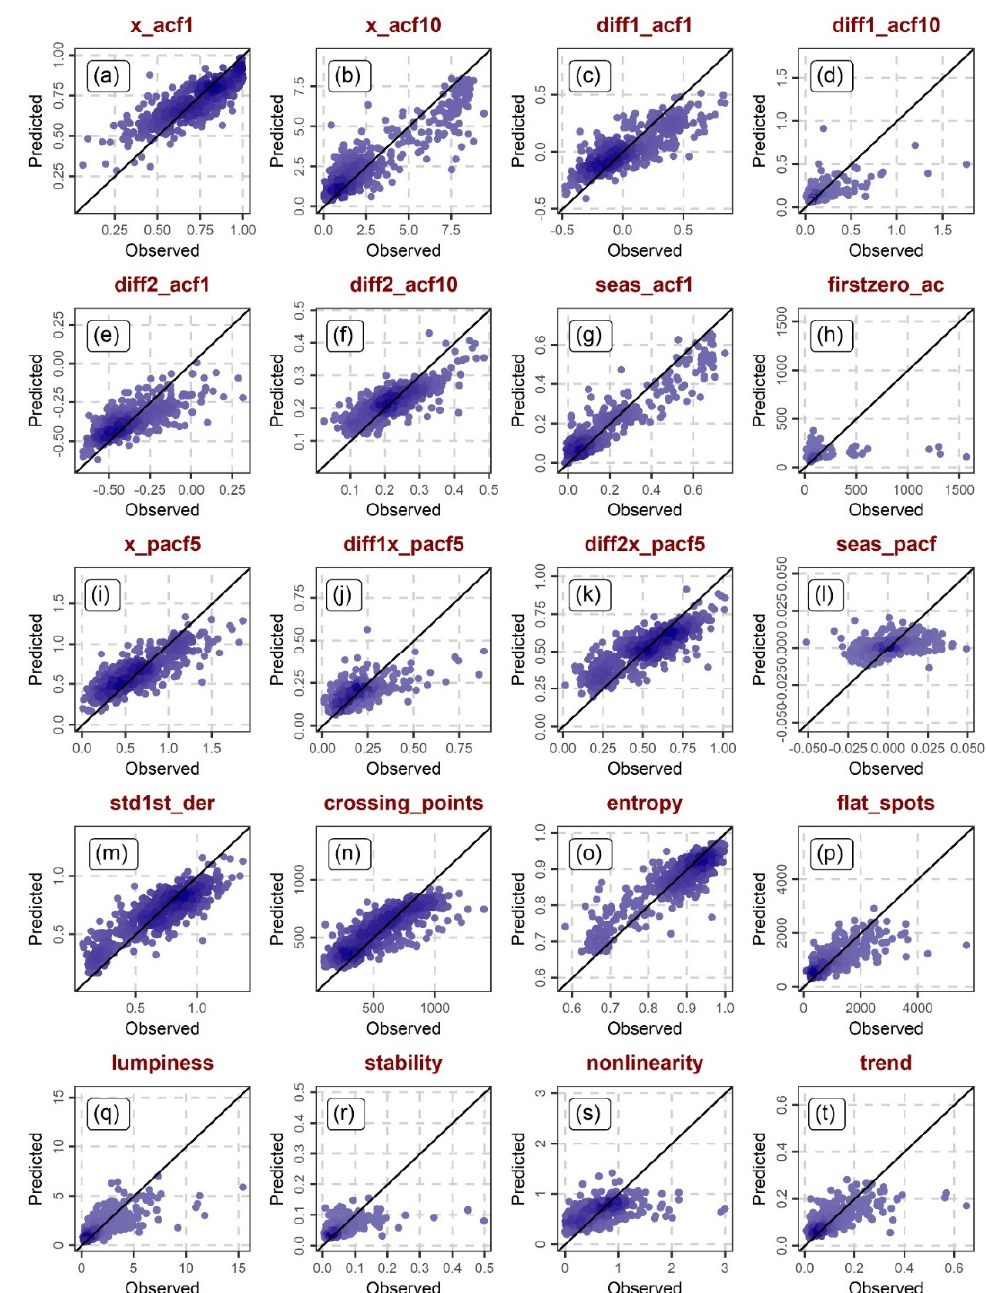
Figure 5. Predicted versus observed daily streamflow features for the 511 investigated catchments when using as predictor variables the total of the static, daily temperature and daily precipitation features under a 10-fold cross-validation setting (part 1). The displayed feature abbreviations are explained in Section 2.2.